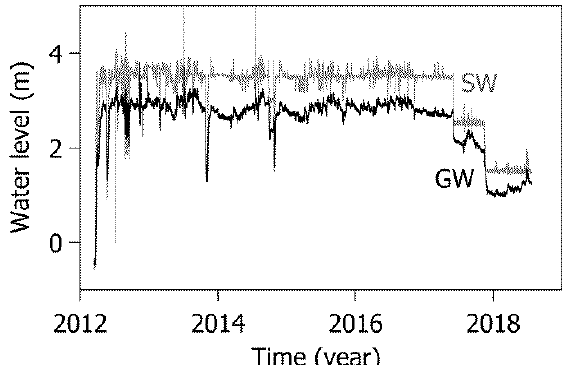
Figure 4. Time series of groundwater level from OW-1 with the corresponding river levels upstream of the Juksan weir.